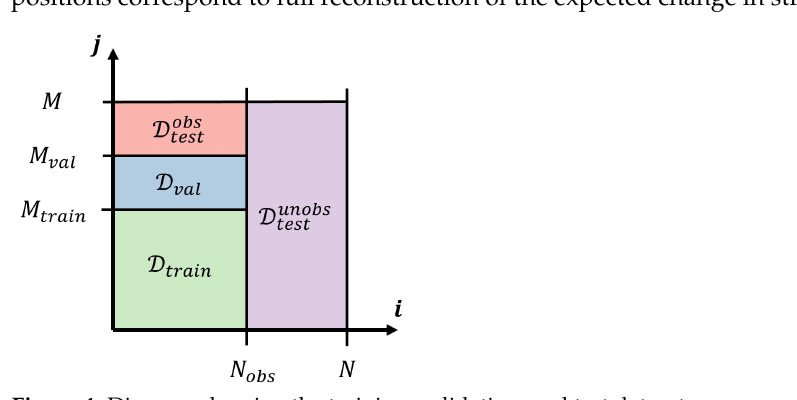
Figure 4. Diagram showing the training, validation, and test